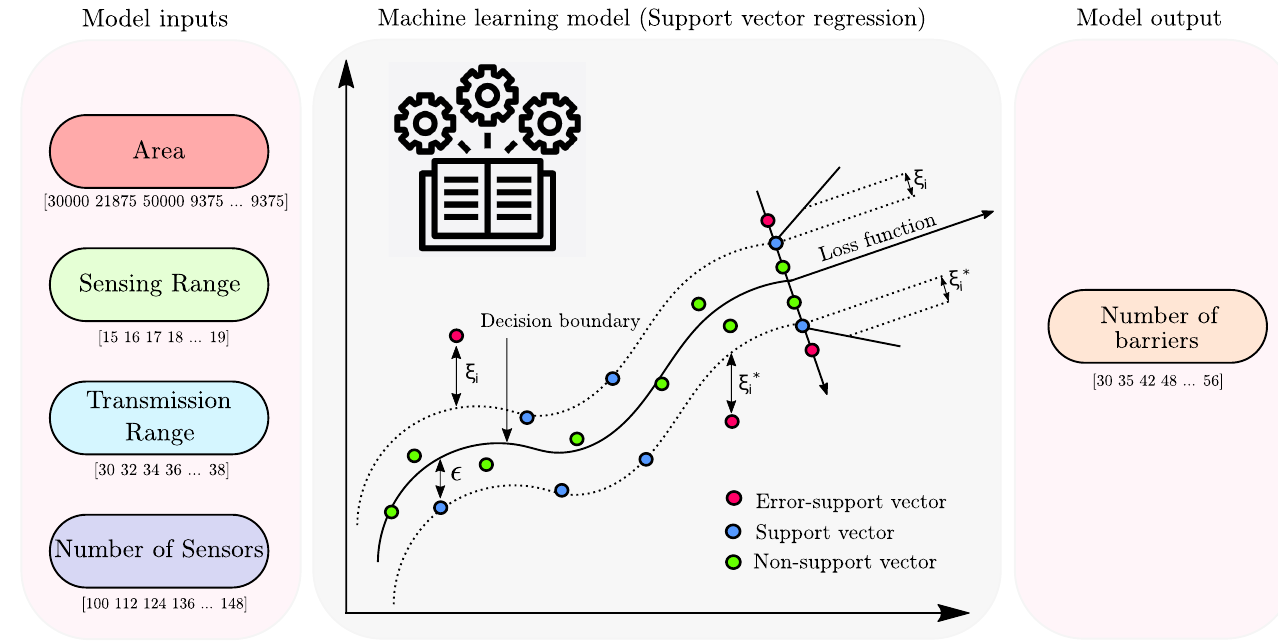
Figure 2. Illustration of the support vector regression with all input features and the corresponding response